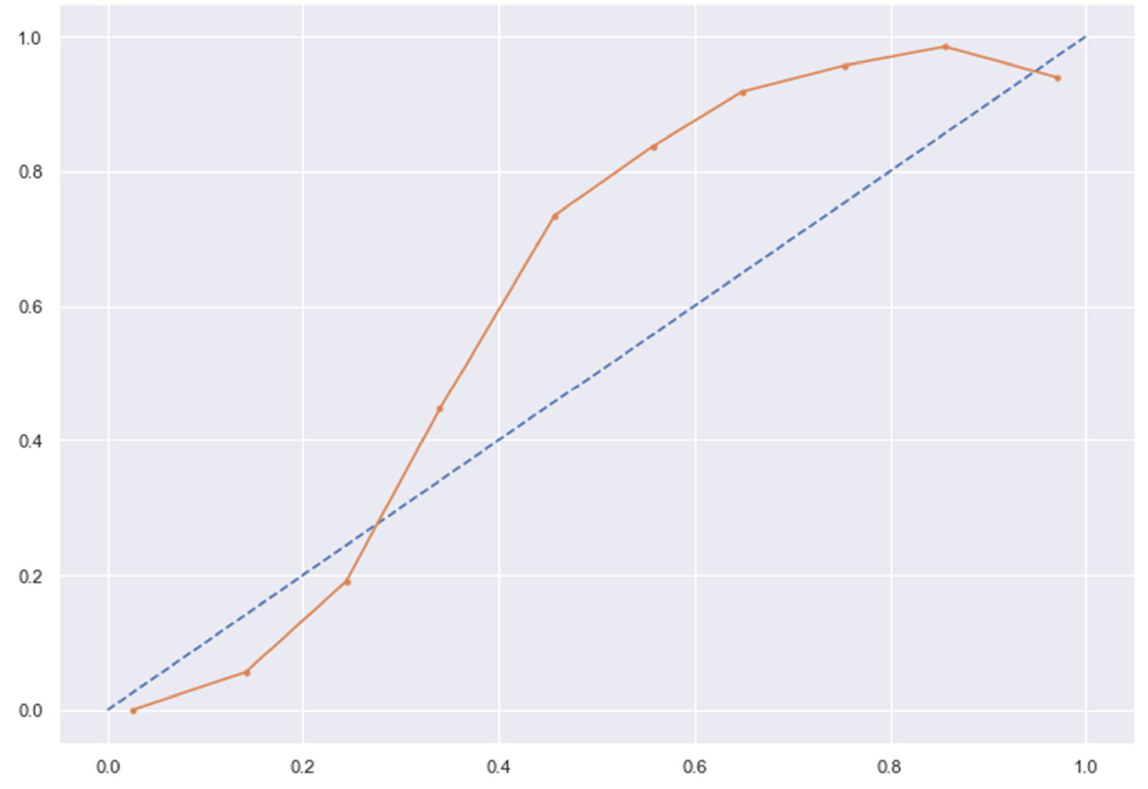
Figure 15. RC line without calibration vs. after calibration (Ideal fit is represented as blue line).